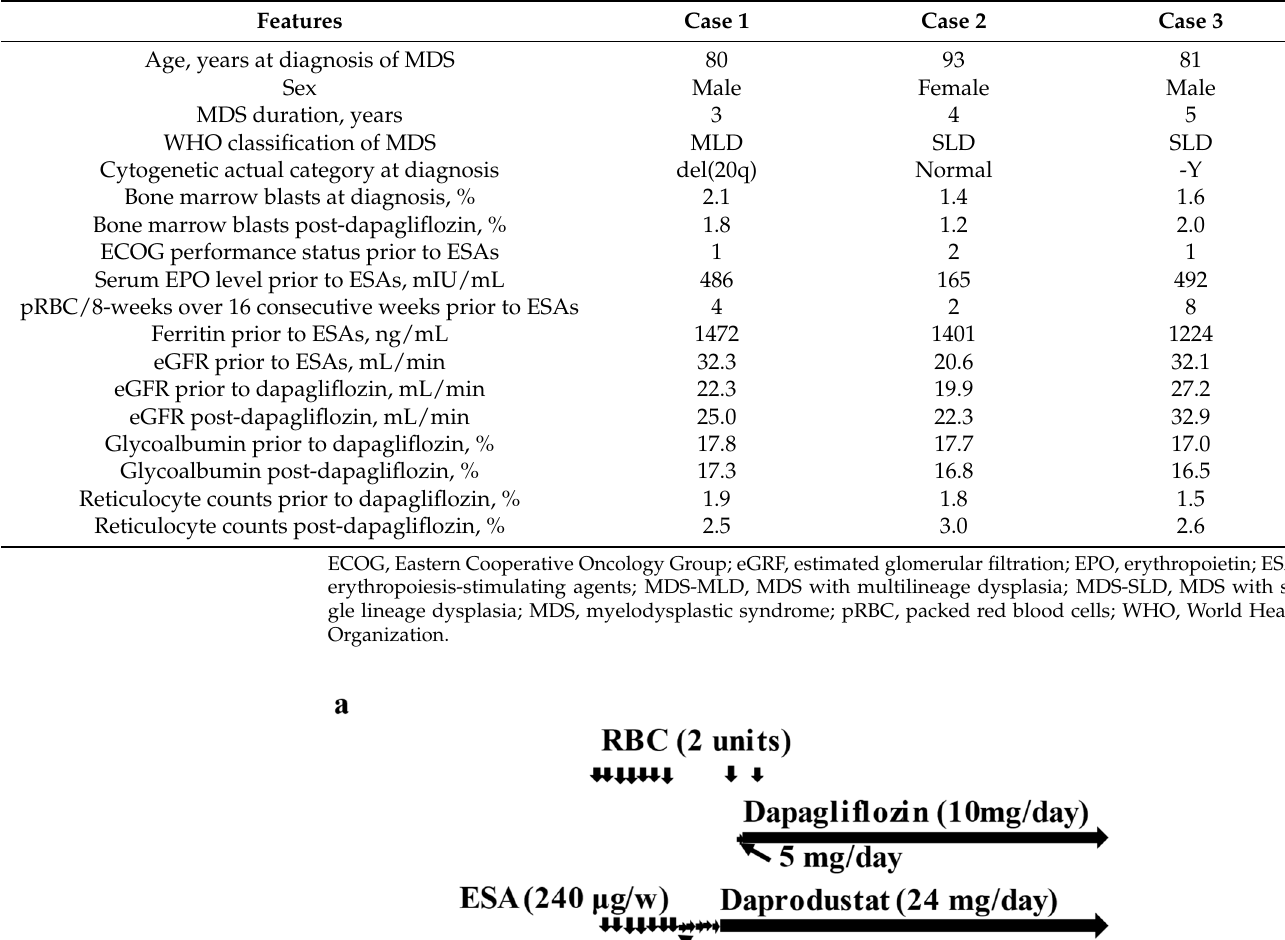
Table 1. Baseline clinical and biologic characteristics.